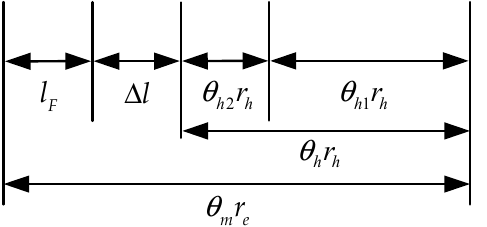
Figure 3. The displacement relationship of the HESY.